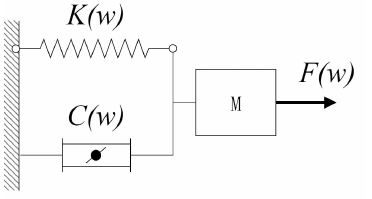
Figure 15. Single-degree-of-freedom vibration